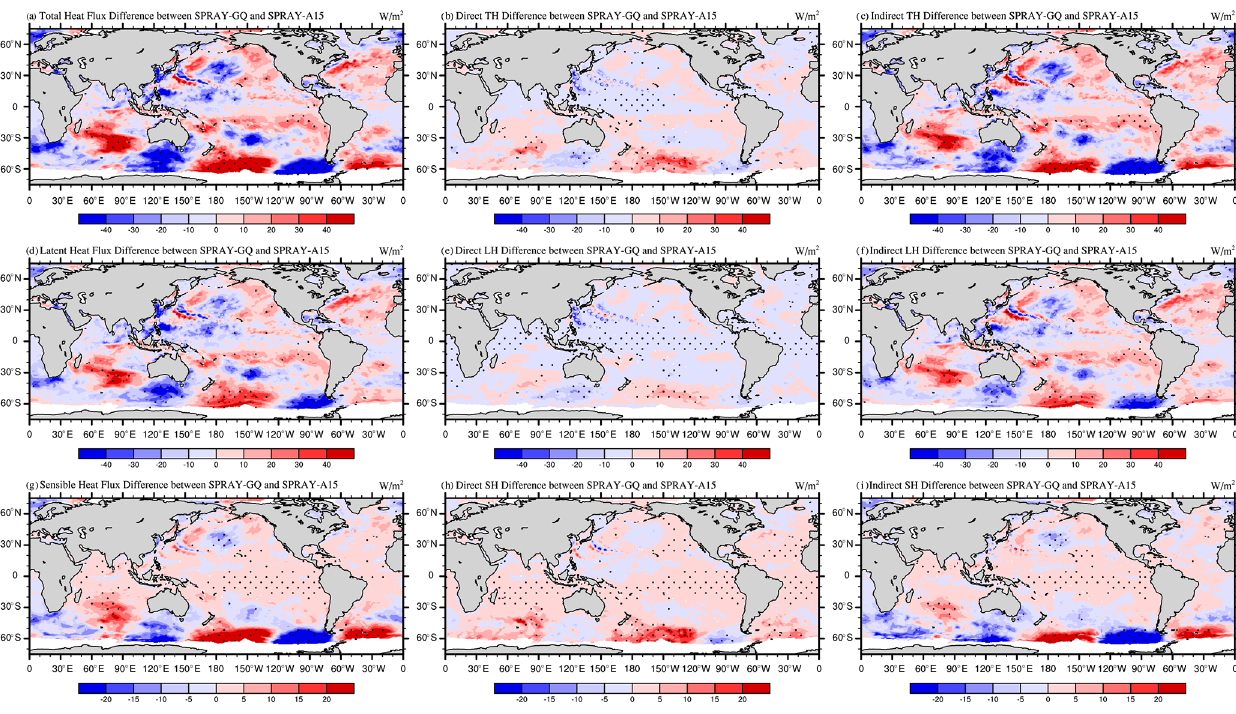
Figure 9. The same as Fig. 7, but for August–September